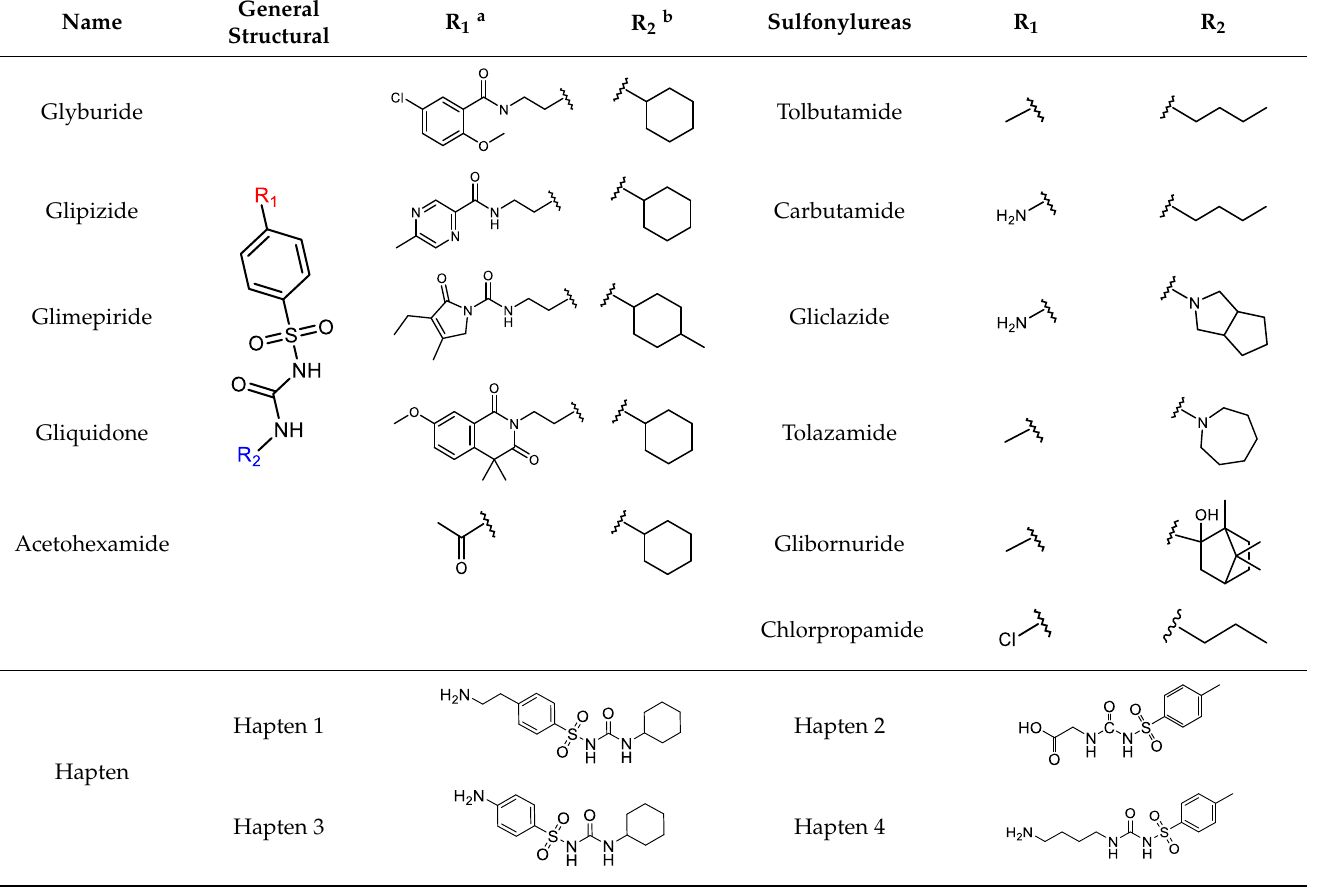
Table 1. Structures and classification of 11 sulfonylureas and the structures of 4 designed hapten.